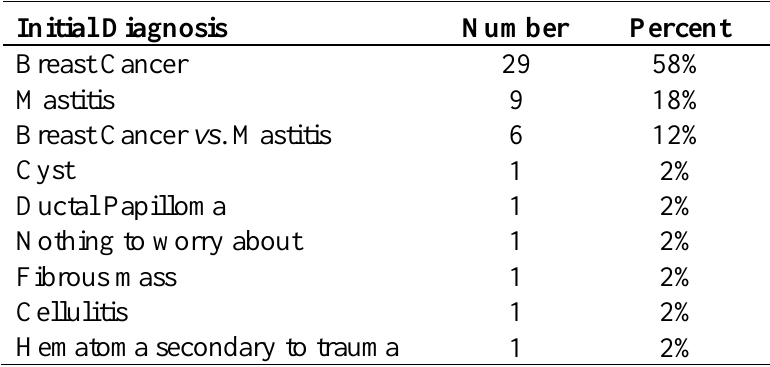
Table 3. Type of Initial Diagnosis for